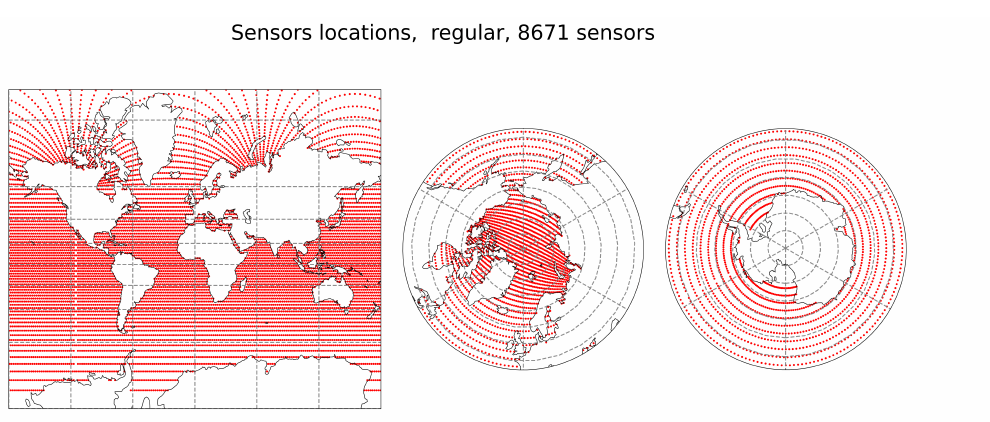
Figure A3. Locations of 8671 sensors regularly placed.